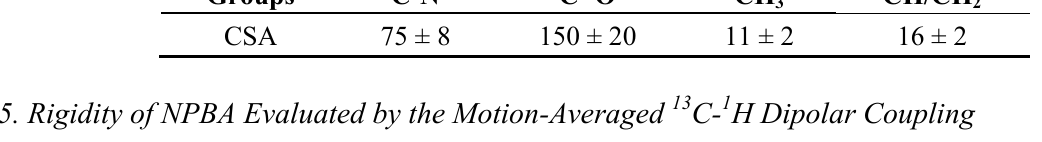
Figure 4. The pulse sequence ( A ) and numerical fittings ( B – E ) of CSA measurements of four different carbon sites in NPBA: ( A ) CN; ( B ) CO; ( C ) CH